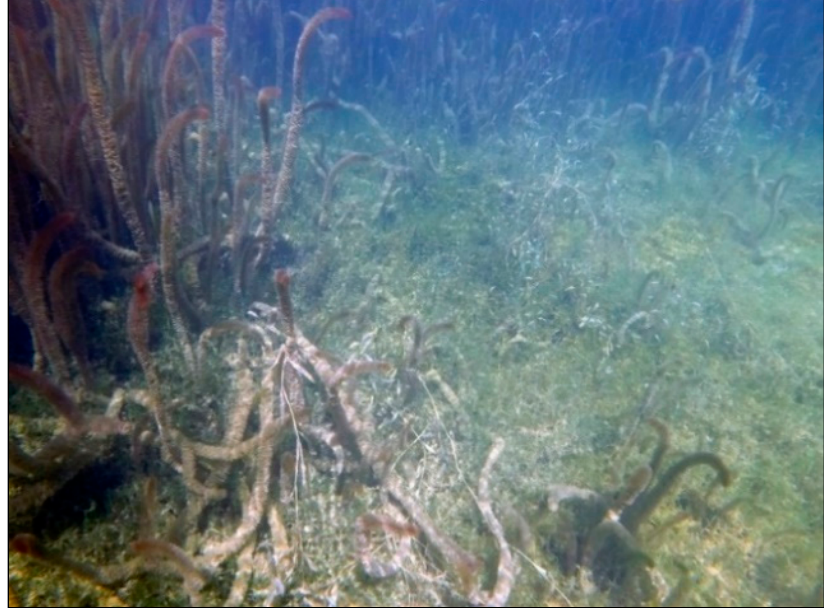
Figure 5. Diverse submerged assemblage, which creates challenges for Lidar and sonar measurements.